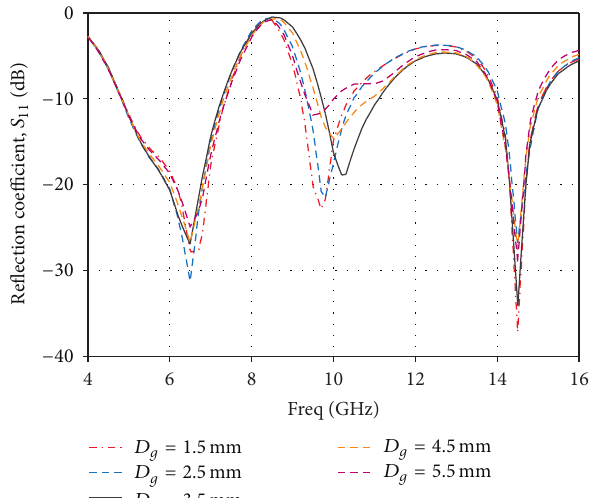
Figure 5: Magnitude of the simulated reflection coefficient of the PIFA versus frequency for different values of the geometrical parameter 𝐷 𝑔